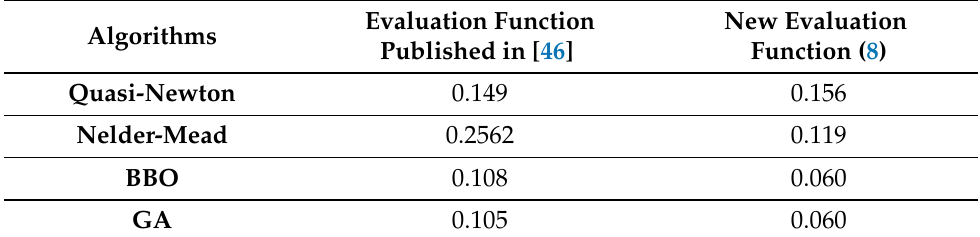
Table 4. Comparison between the evaluation function published in [46] and the new evaluation function in (8).